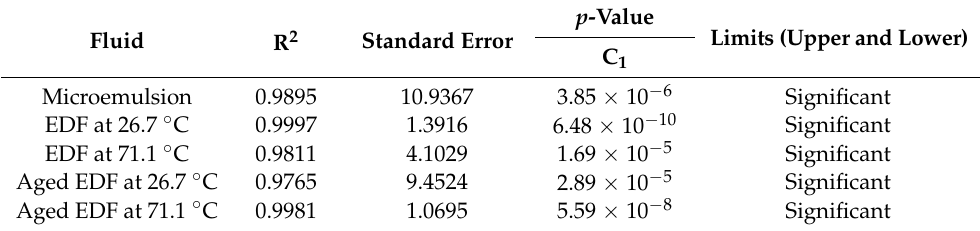
Table 5. Statistical analyzes of approximation to the Herschel–Bulkley model by microemulsion and EDF drilling